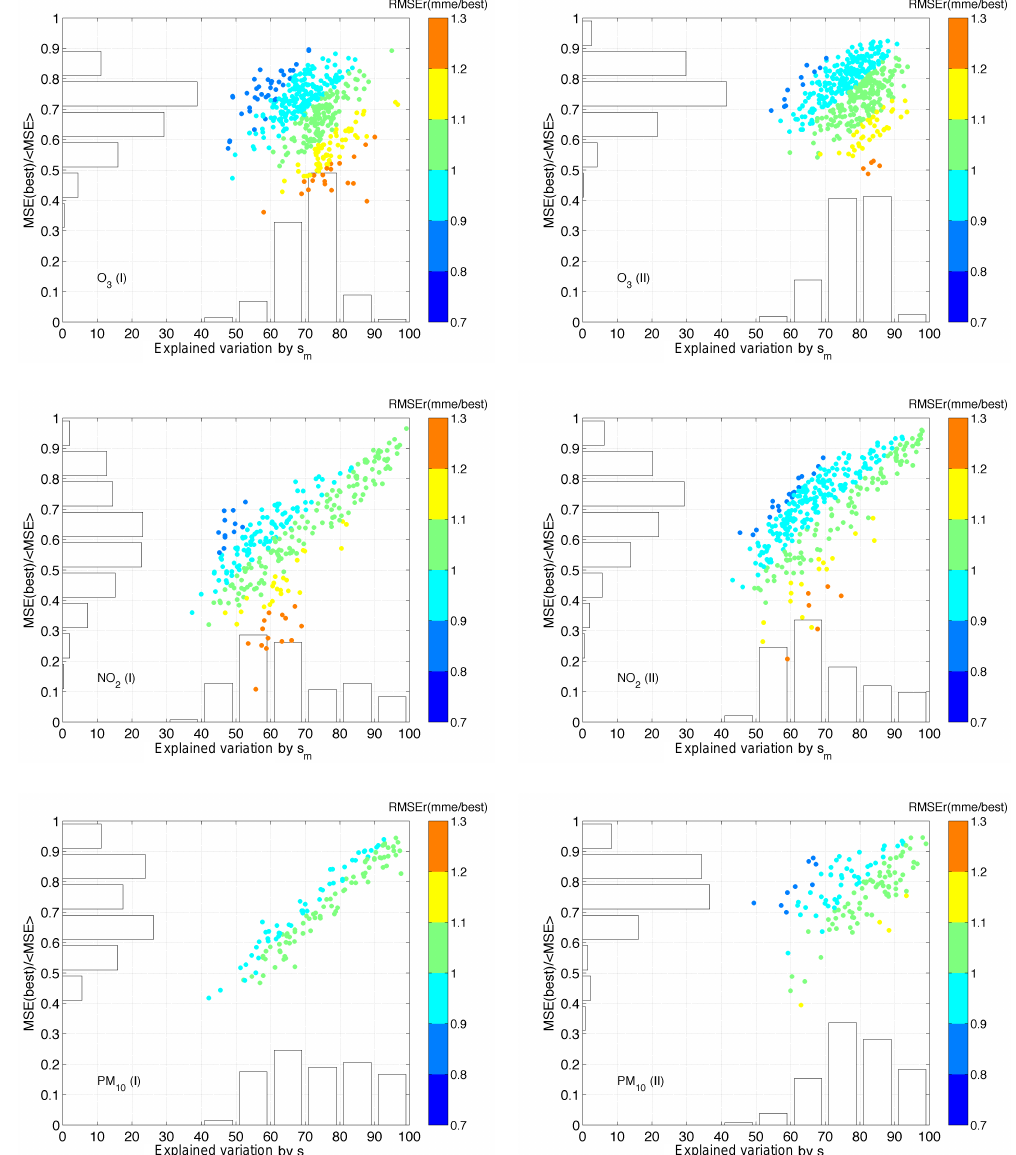
Figure 5. Interpretation of Fig. 3: the explanation of the mme skill against the best local deterministic model with respect to skill difference (evaluated from MSE BEST / < MSE > ) and error dependence (evaluated from the explained variation by the highest